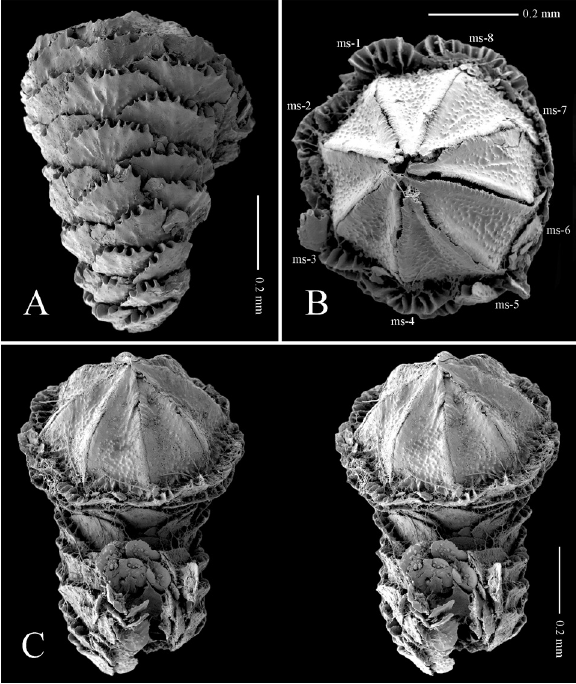
Fig . 24. – Primnocapsa plumacea (Thomson and Mackinnon, 1911) n. comb., holotype (AM G12123): A, polyp on abaxial view; B, polyp on oral view; C, polyp on adaxial view, stereo pair. [ms= marginal